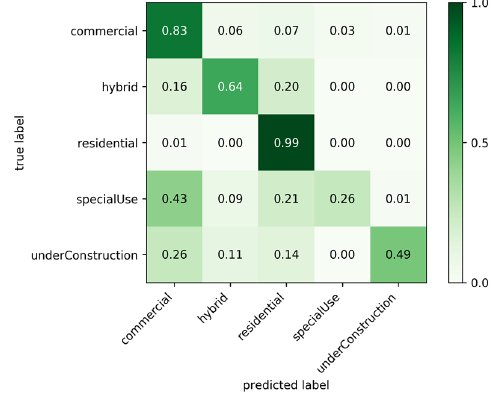
Figure 3. Normalized confusion matrix of the best- performing network (pretrained InceptionV3 on ImageNet) when being evaluated on our 5-class test set.